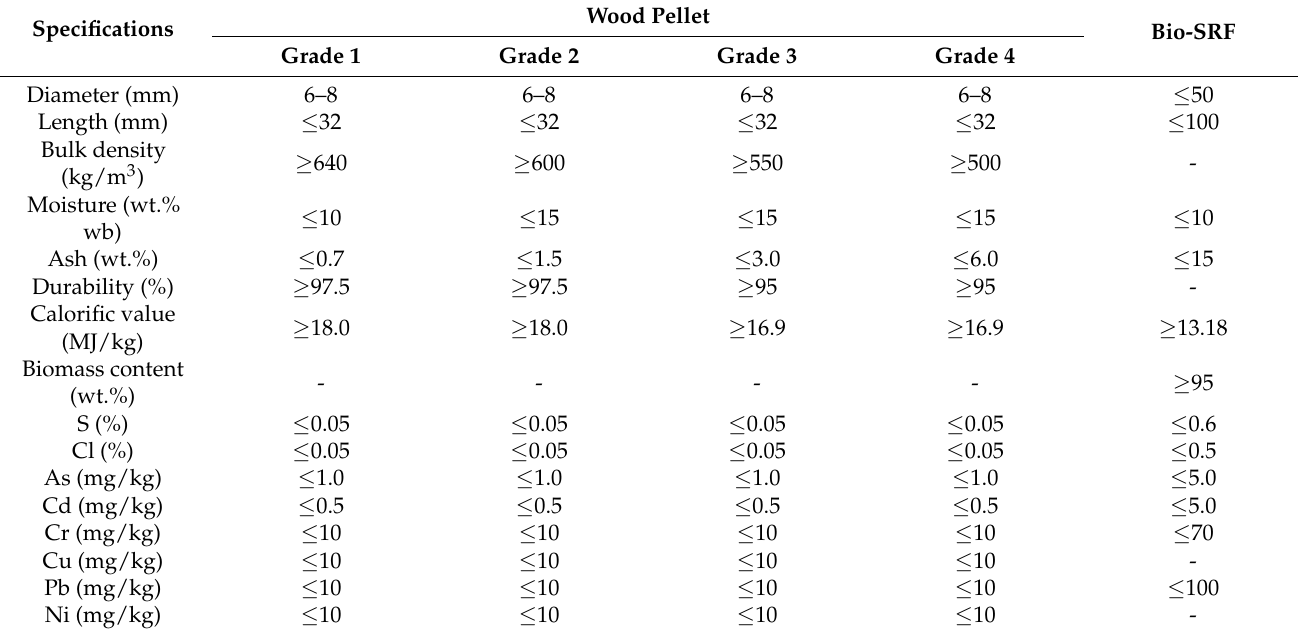
Table 4. Quality standards for wood pellet and bio-solid refuse